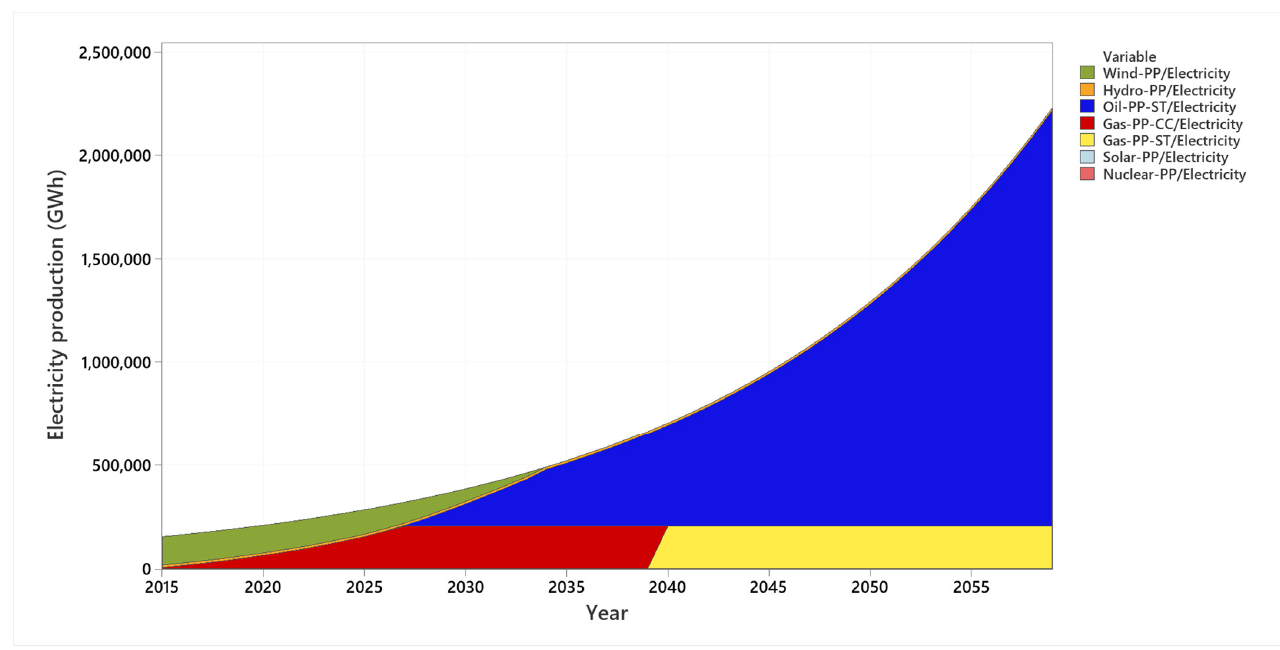
Figure 7. Balance of electricity production of all power plants for second scenario.